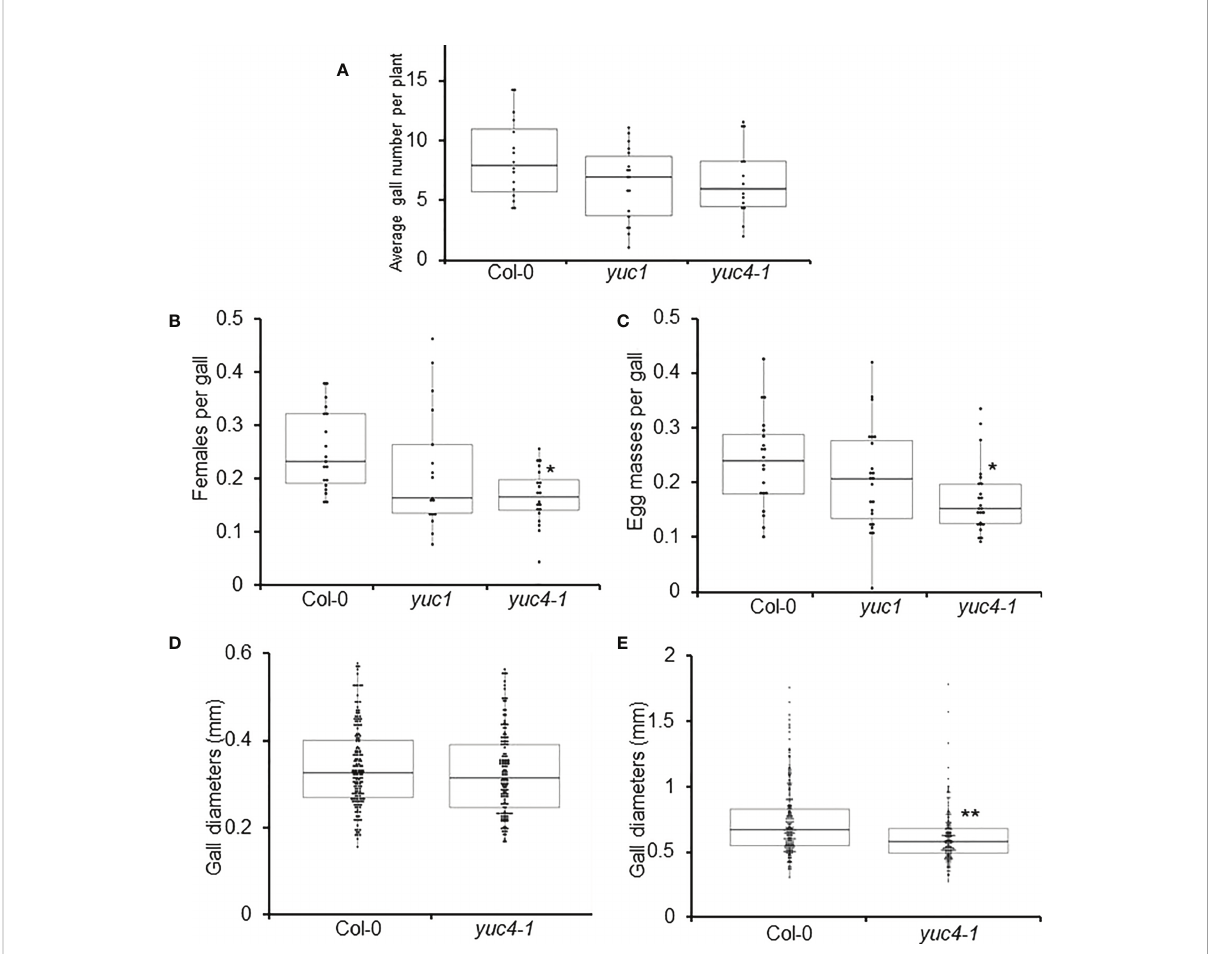
FIGURE 5 YUC4 positively regulates RKN development and fecundity. Average gall numbers per plant at 14 DPI (A) , emerged RKN adult females per gall (B) , and egg masses per gall (C) in Col-0, yuc1 and yuc4-1 plants. (D, E) Diameters of 7 DPI (D) and 42 DPI galls (E) in Col-0 and yuc4-1 plants. Each data point in (A) represents average value from 6 plants. Boxplots of n ≥ 204 are shown. Three biological replicates were performed with similar results. Asterisks denotes signi fi cance from Col-0, *P<0.05, **P<0.01, generalized Wilcoxon rank sum test corrected for multiple